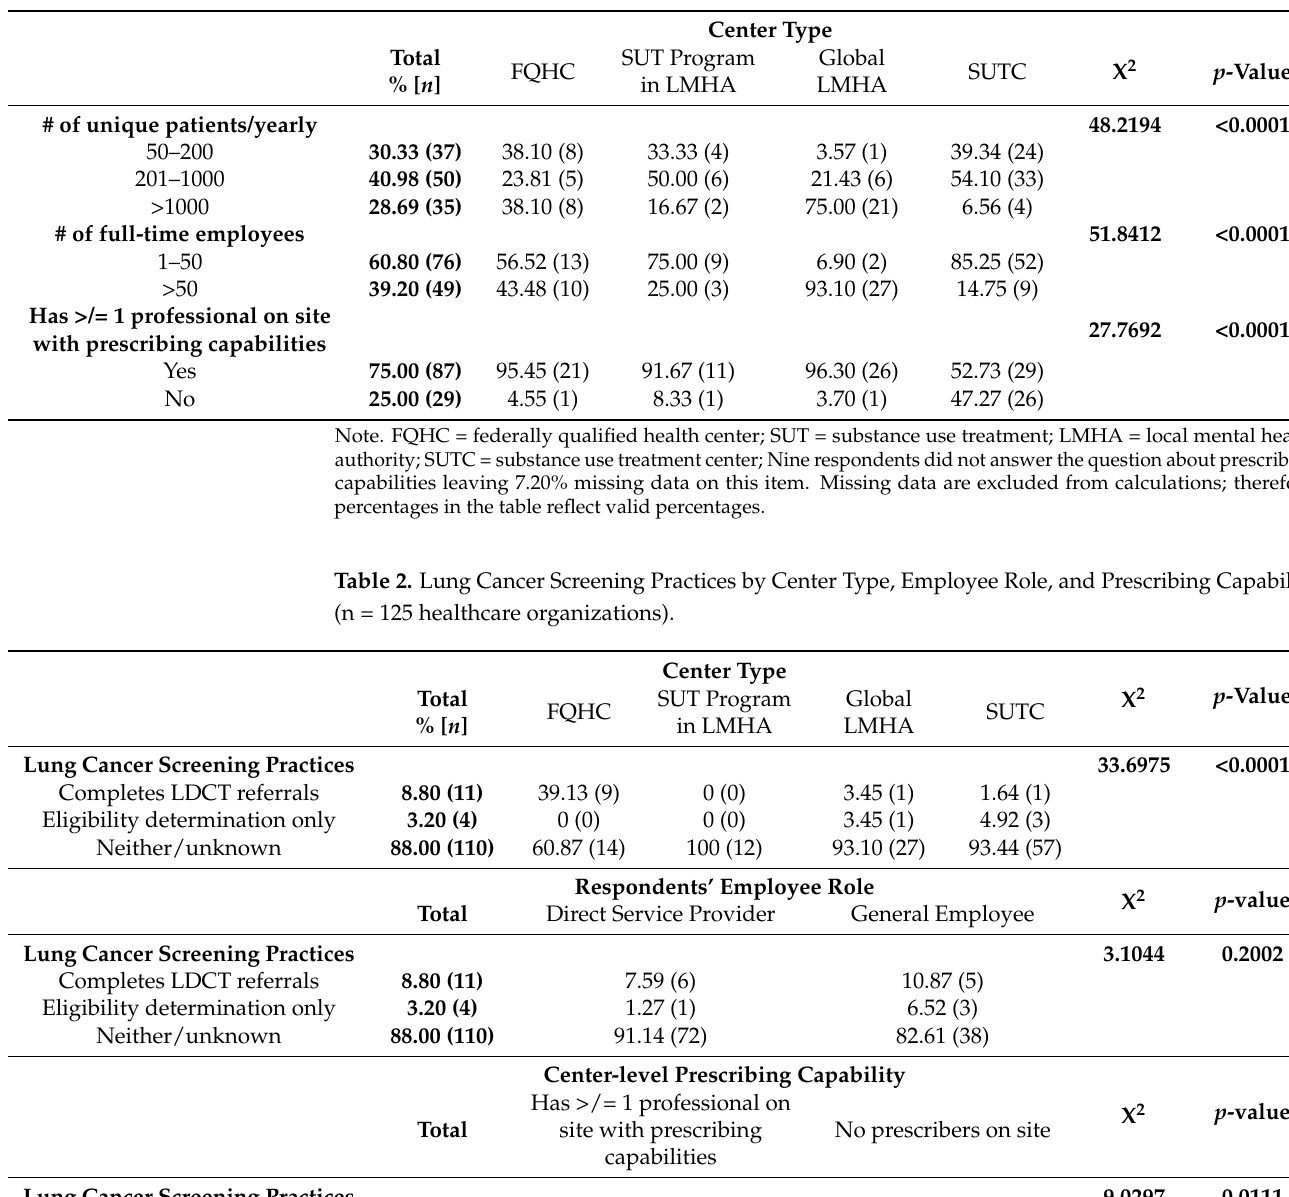
Table 1. Center-level characteristics (n = 125 healthcare organizations).